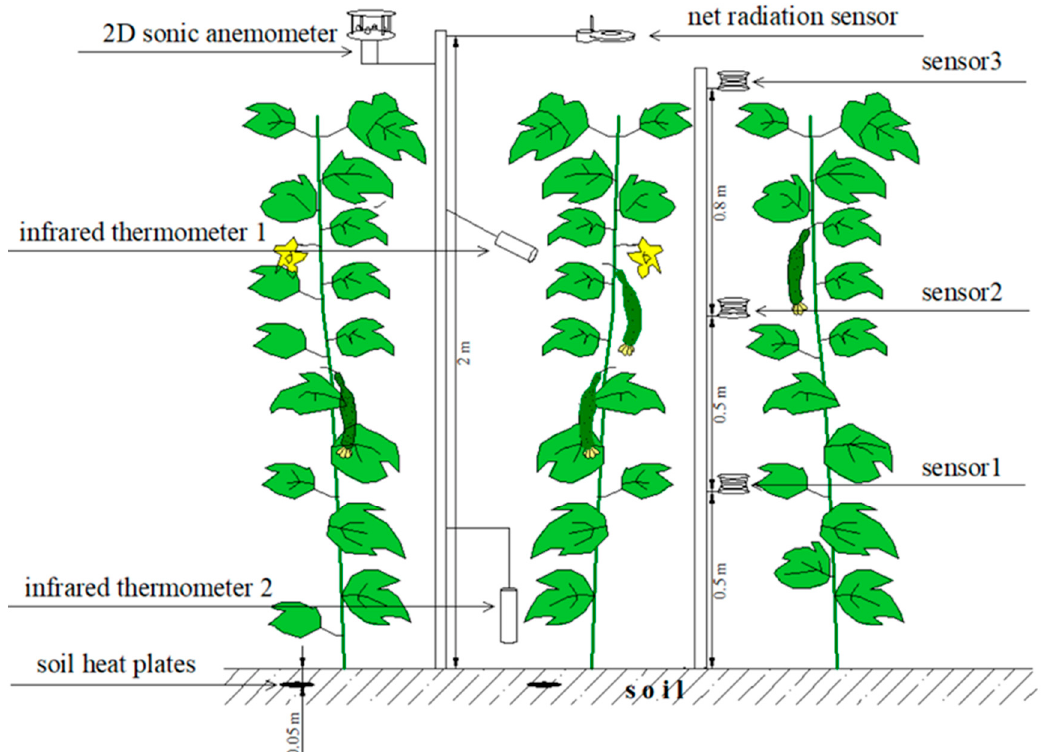
Figure 1. A schematic view of the sensor locations.